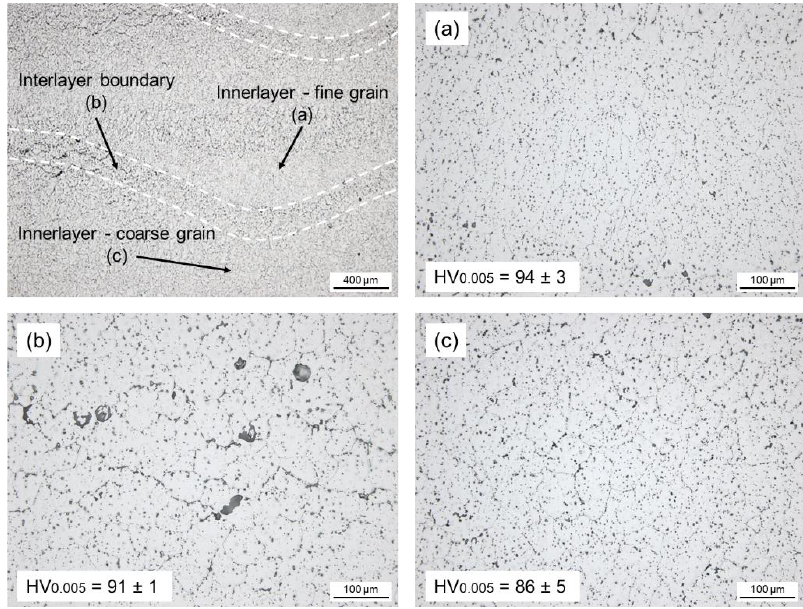
Figure 10. Microstructure and micro hardness of innerlayer fine grain ( a ), interlayer boundary ( b ) and innerlayer coarse grain ( c ) regions for Series A specimen with t i = 120 s.